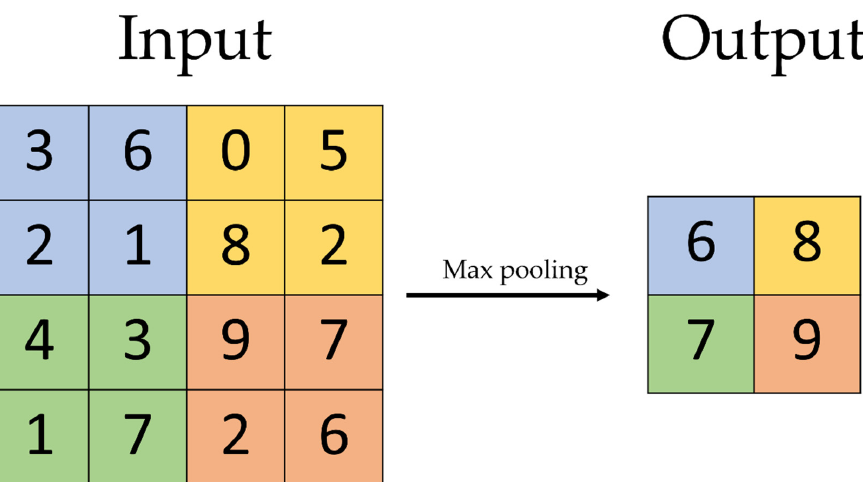
Figure 5. Max pooling layer: the input layer (left) is filtered by a 2 × 2 max pooling layer computing the output with the highest activation (number) of the filtered area in the preceding layer into a smaller output layer. One can imagine a 2 × 2 filter starting on the top left: The first filtered area will be the blue area. The number six, being the highest, will be computed as 1 × 1 in the output, representing the 2 × 2 input. After that, the filter will go to the next area that has not been filtered, e.g., two cells to the right, and repeat the process. With filtering methods like this, the required computational power can be reduced.